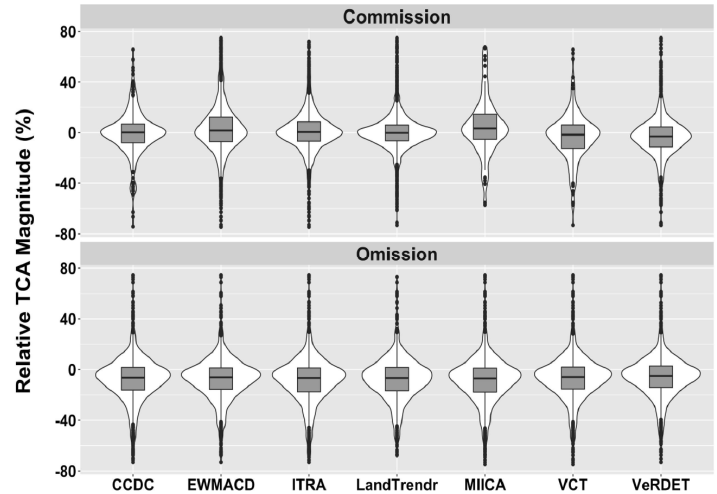
Figure 7. Relative magnitude distributions for omission and commission occurrences from each of the seven map products. Table 3. Map omission by TimeSync disturbance causal agent